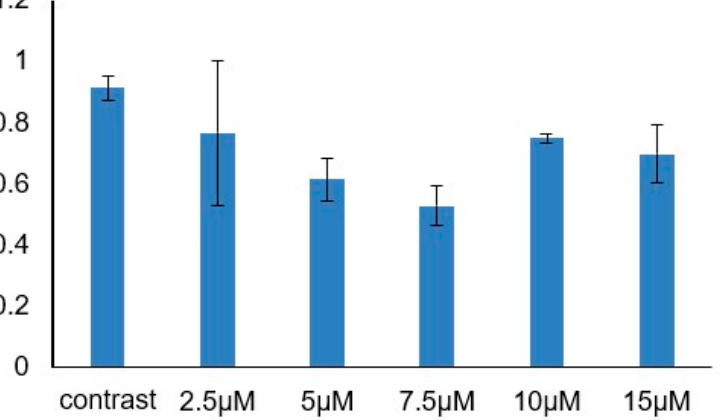
Figure 2. Ginsenoside content of ginseng hairy roots were treated with different concentrations. The abscissa is the concentration of GA and the ordinate is the content of total ginsenosides.